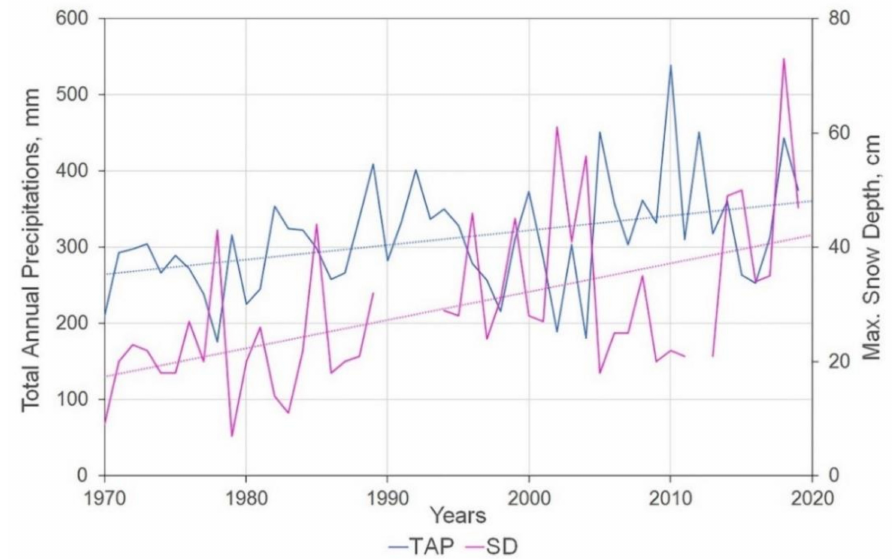
Figure 3. Changes in total annual precipitation (TAP) and maximum snow depth (SD) over time, based on the data obtained from the Marre-Sale weather station, 1970–2019. Dotted lines show linear trends in changes of